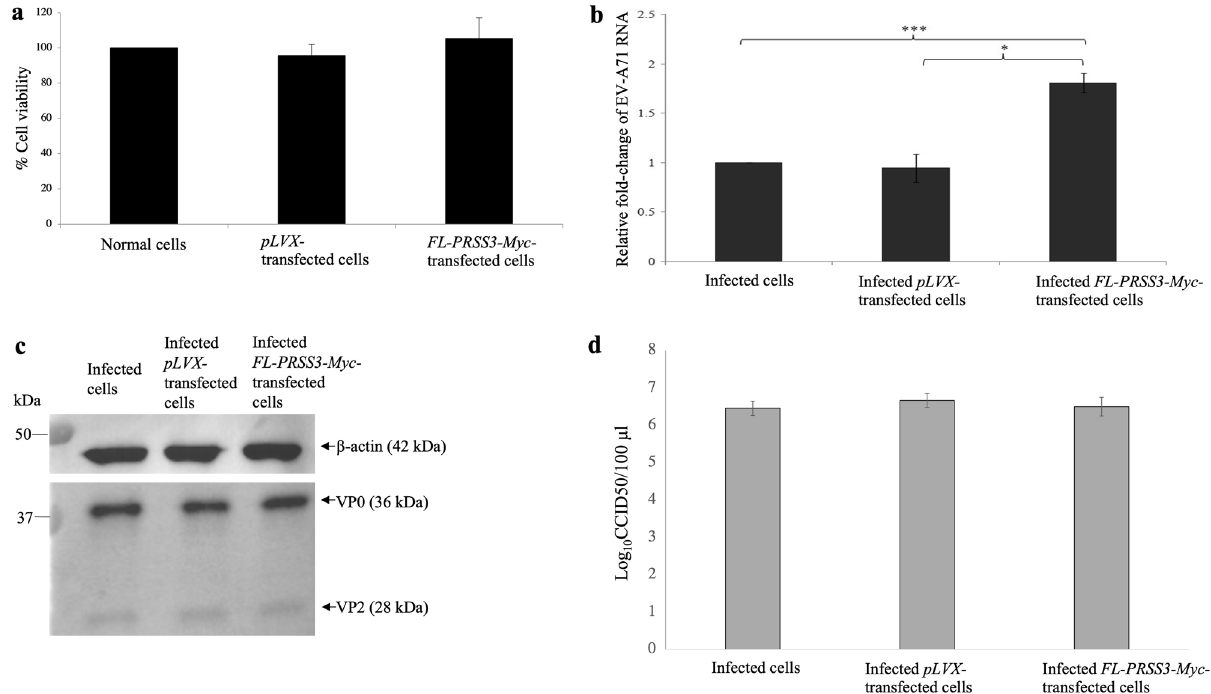
Figure 6. Determination of relative fold-changes of EV-A71 RNA copy numbers by qRT-PCR in response to overexpression of the neuron-derived PRSS3 in pLVX::FL-PRSS3-Myc -transfected HEK293T cells. ( a ) Cytotoxicity of the FL-PRSS3-Myc to HEK293T cells was determined by SRB assay. ( b ) The relative fold- changes of EV-A71 RNA copy numbers in response to overexpression of the FL-PRSS3-Myc. The pLVX::FL- PRSS3-Myc -transfected HEK293T cells infected with EV-A71 were designated as EV-A71-infected pLVX::FL- PRSS3-Myc -transfected cells. Mock transfected and pLVX- transfected HEK293T cells infected with EV-A71 served as infection control and empty vector control, respectively. ( c ) Western blot analysis of EV-A71 protein synthesis upon overexpression of the FL-PRSS3-Myc when compared with the control groups. The EV-A71 proteins detected by anti-EV-A71 antibody are VP0 (MW = 36 kDa), pre-cleavage product of VP2, and VP2 (MW = 28 kDa). Human β-actin (MW = 42 kDa) was used for normalization of protein loading. Data were expressed by mean ± SD from three independent experiments in triplicate measurements (N = 9). ( d ) The titers of virus released from cells overexpressed PRSS3, pLVX-Puro -transfected- and untransfected cells were determined by CCID50 method. The data was derived from three independent experiments. Statistical analysis was done by One-way ANOVA with post-hoc tests. Levels of statistically significant difference at p < 0.05 and p < 0.001 were indicated by * and ***, respectively. The original blots of ( c ) were shown in Supplementary Fig.